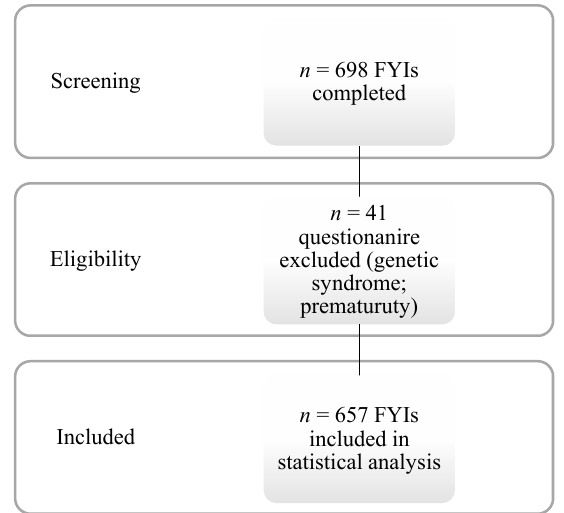
Figure 1. Flowchart of study sample and design.